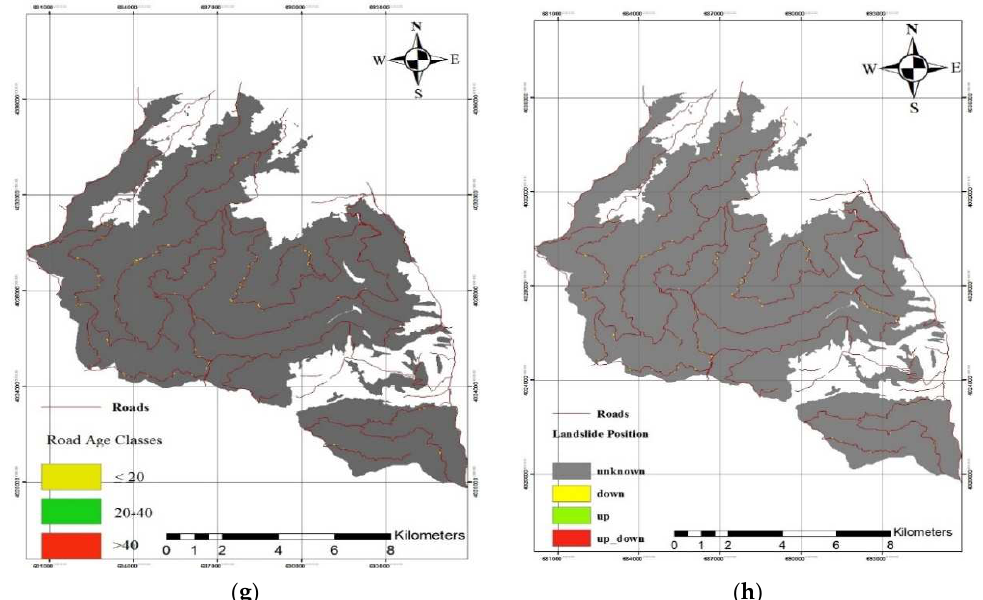
Figure 3. Maps of landslide-conditioning factors: ( a ) slope; ( b ) aspect; ( c ) altitude; ( d ) rainfall; ( e ) geology; ( f ) soil; ( g ) road age; ( h ) slip position. Description: Soil texture map (2.2.1: Loam, Clay-Loam, 2.2.2: Silt-Clay-Loam, Clay-Loam, 2.2.3: Loam, Clay-Loam, Clay, 2.2.4: Clay-Loam, Si-Clay). Geology map (L-PLL4: Lime Marine Rock, Sand Lime Rock, L-PLL3: Sand Lime Rock, Lime Silt Rock, Lime Marine Rock, Marine Rock, Conglomerate Rock, L-PLL2: Lime Marine Rock, Marine Rock, Sand Lime Rock, Lime Silt Rock, L-PLL1: Lime Marine Rock, Lime Rock, Marine Rock, Sand Lime Rock, Lime Silt Rock, L-R: River alluviums, l-ml2: Sand Lime Rock, Conglomerate Rock, l-ml3: Lime Silt Rock, Marine Rock, L-K2l2: Sand Lime Rock, Lime Marine Rock, L-Pel1: Conglomerate Rock).